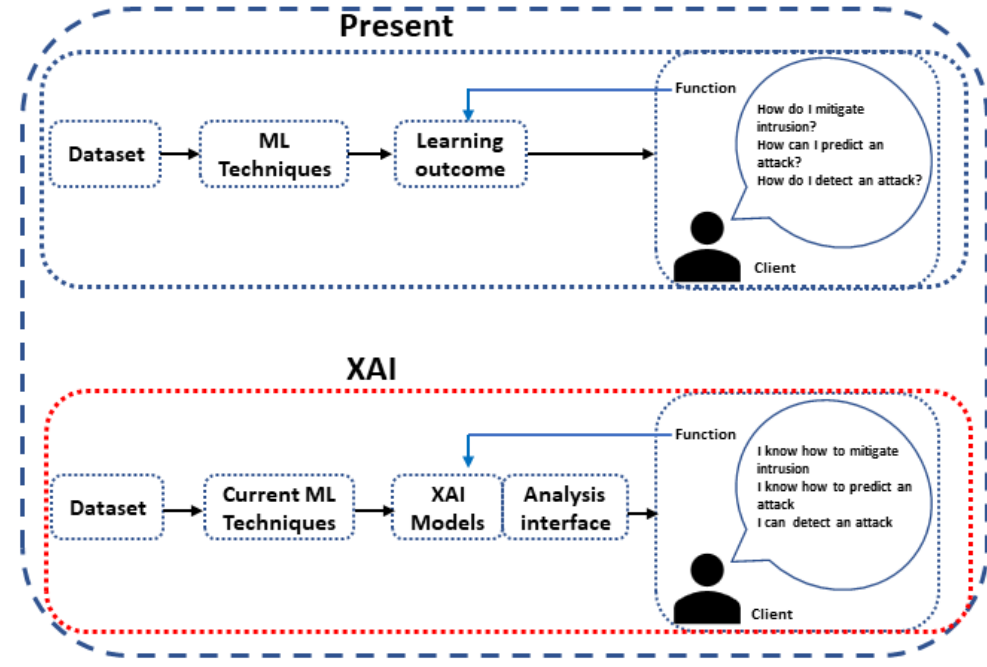
Figure 3. The concept of